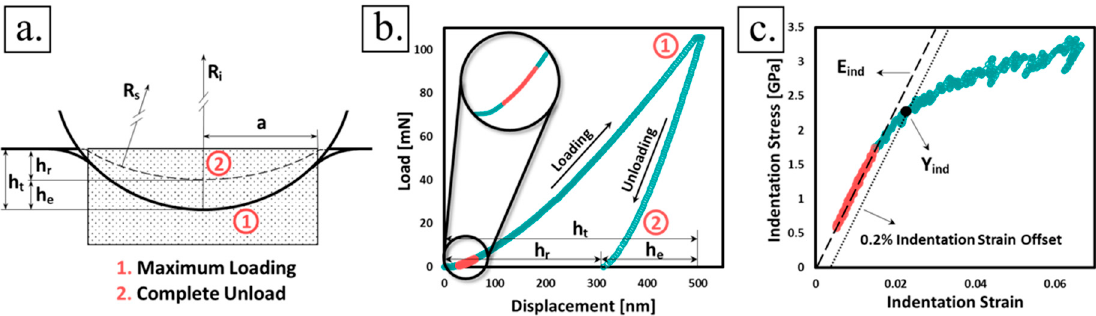
Figure 1. ( a ) Schematic description of the spherical indentation experiment depicting the loaded and unloaded configurations. ( b ) Measured load-displacement curve from a typical spherical indentation measurement, with a zoomed view of the early loading segment. ( c ) Indentation stress-strain (ISS) curve extracted from the load-displacement data with the elastic region of the deformation highlighted in red.